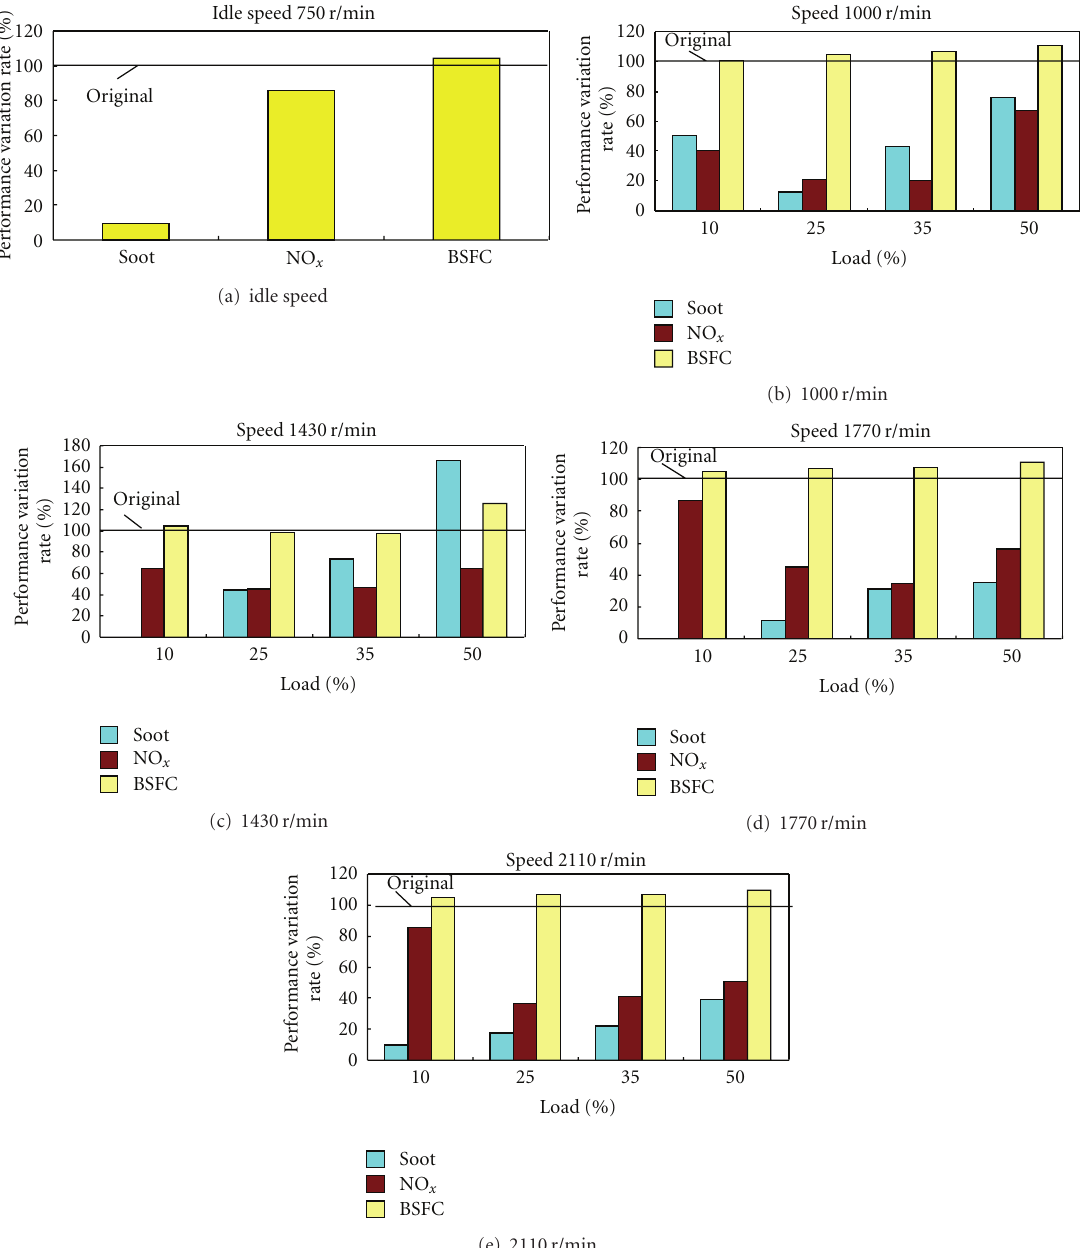
Figure 14: NO x , soot, and BSFC of premixed combustion variation rate compared with the original engine at di ff erent test operating